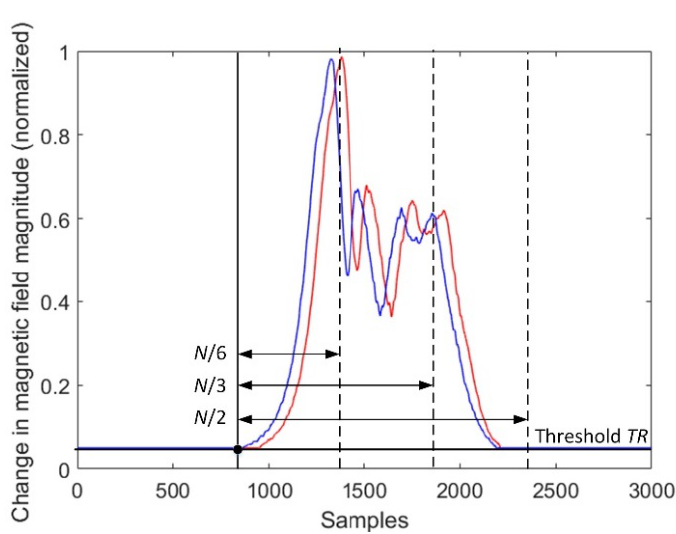
Figure 5. The effect of diminishing the sample size by dividing.